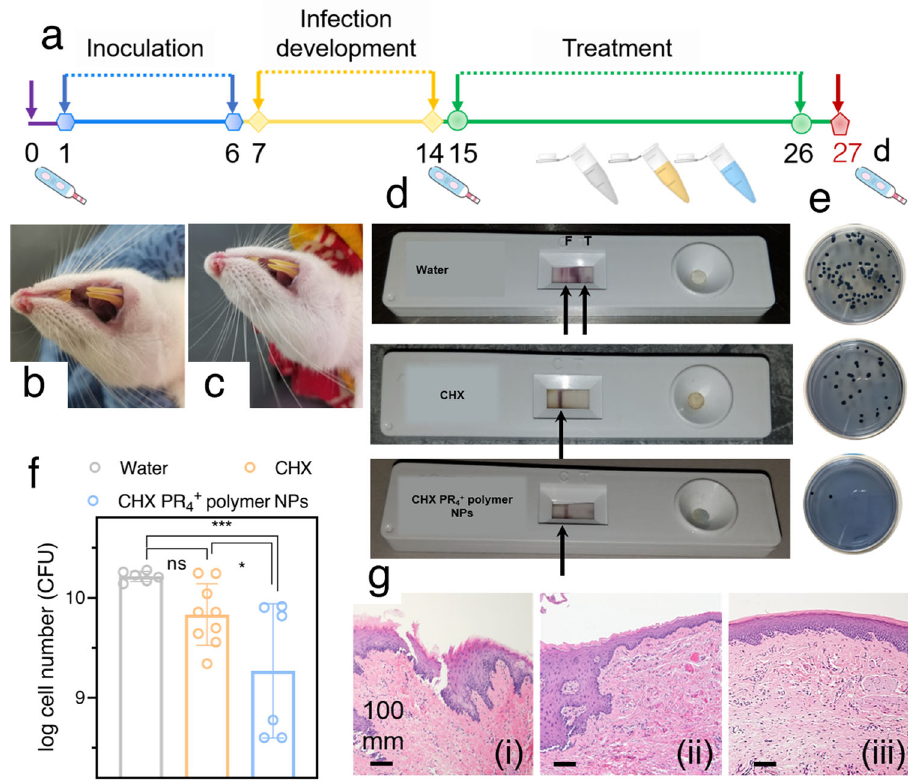
Fig. 7 The in vivo ef fi cacy of the NPs in a rat model of the dental bio fi lm. a Timeline of the in vivo animal treatment, the treatments (water, CHX, and CHX PR 4 + polymer NPs) are represented in the centrifuge tubes; the dental hygiene in the animal model b before treatment and c after treatment with NPs; d the outcomes of the in vivo S. mutans detection kit; the results were positive for the water-treated group and negative for CHX- and CHX PR 4 + polymer NP-treated groups; e the cultivable bacteria collected from the harvested animals ’ teeth. Bacitracin-modi fi ed mitis salivarius agar plates, which can speci fi cally grow S. mutans , have been employed here. f The collective results from the plate count assay of the cultivable bacteria after obtaining their jaws ( n = 3 biological replicates); ordinary one-way ANOVA, p value < 0.1 and 0.001 are indicated by * and ***, respectively. Error bar represents mean ±